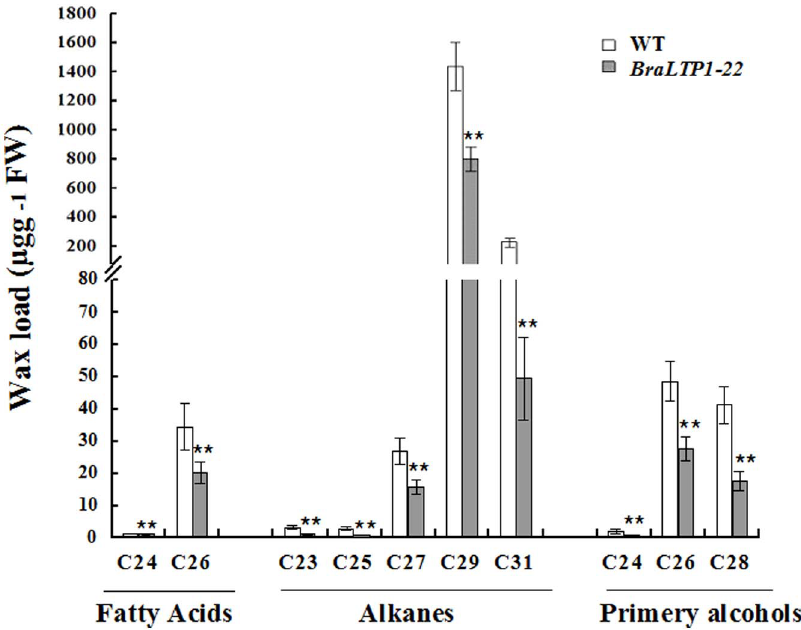
Figure 5. Cuticular wax composition and loads in leaves of BnaLTP1-22 overexpression line and wild type (WT) B.napus . Error bars indicate SE of three 6 biological repeats (t-test: **P , 0.01).